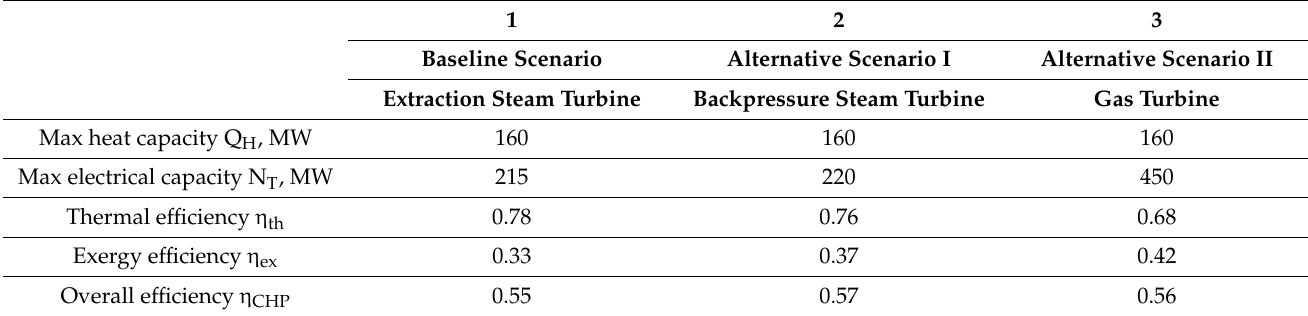
Table 1. Comparison of energy supply source indicators.